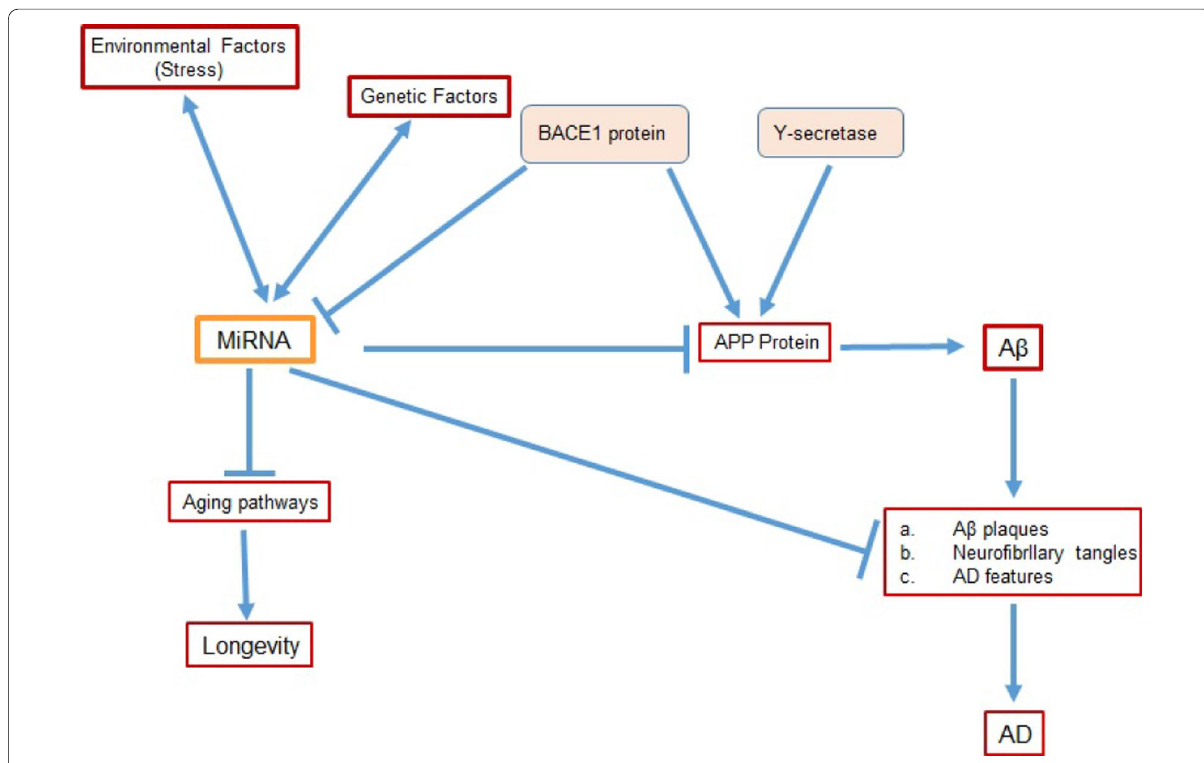
Fig. 2 Alzheimer’s disease (AD) formation, longevity and miRNA